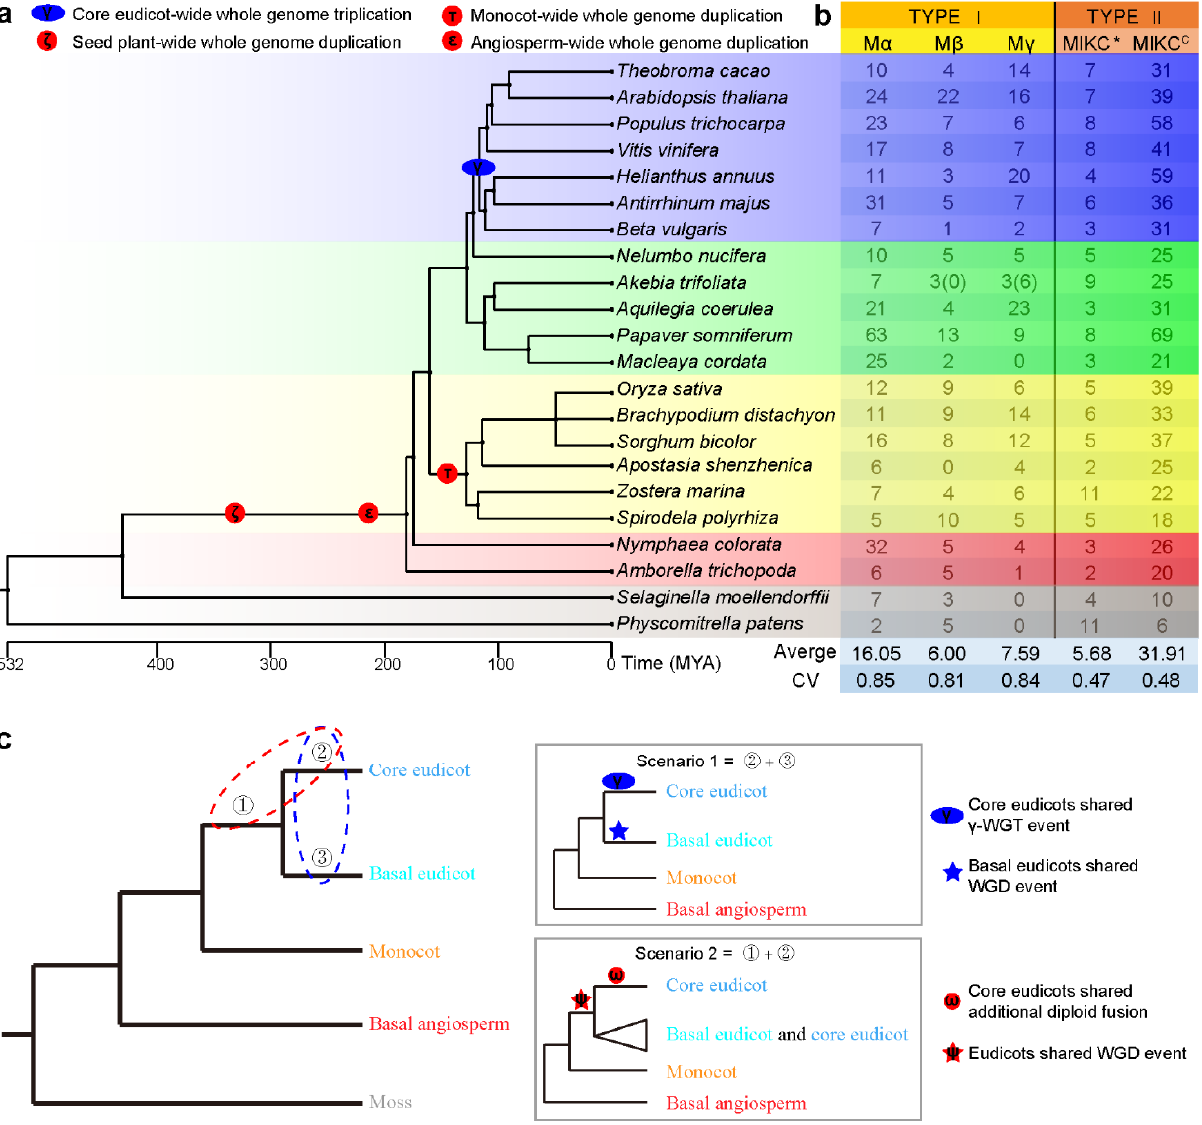
Figure 4. Diversification of MADS-box genes in land plants. ( a ) Phylogeny of 22 plant species. The topology of the tree was referenced from the TimeTree database, and four ancestral polyploidy events in seed plants were marked according to a previous report [44]. ( b ) Total number and classification of MADS-box genes in 22 plant species. CV: coefficient of variation. ( c ) Hypothetical duplicate genes of MADS-box origination from ancestral polyploidization events.